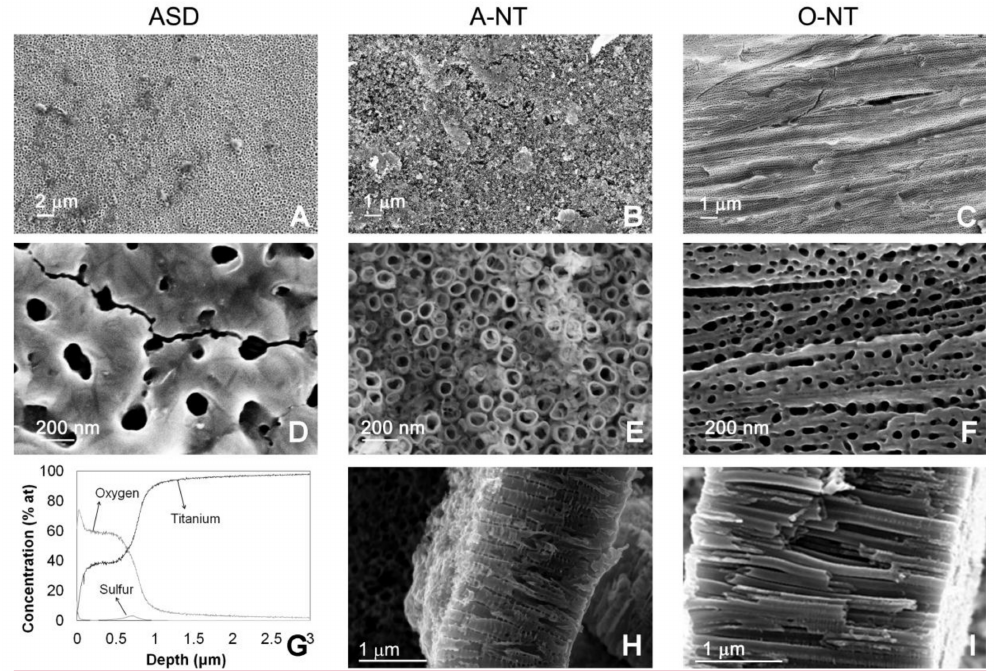
Figure 1. SEM micrographs of morphologies deriving from ASD ( left ), anodizing in aqueous solution with 4.5 h of anodizing (nanotubes, center ) and in organic solution with 0.5 h of anodizing (nanopores/nanotubes, right ) at different magnifications. The lower line reports information to derive oxide thickness: GDOES analysis for ASD samples, cross sections for nanotubes.